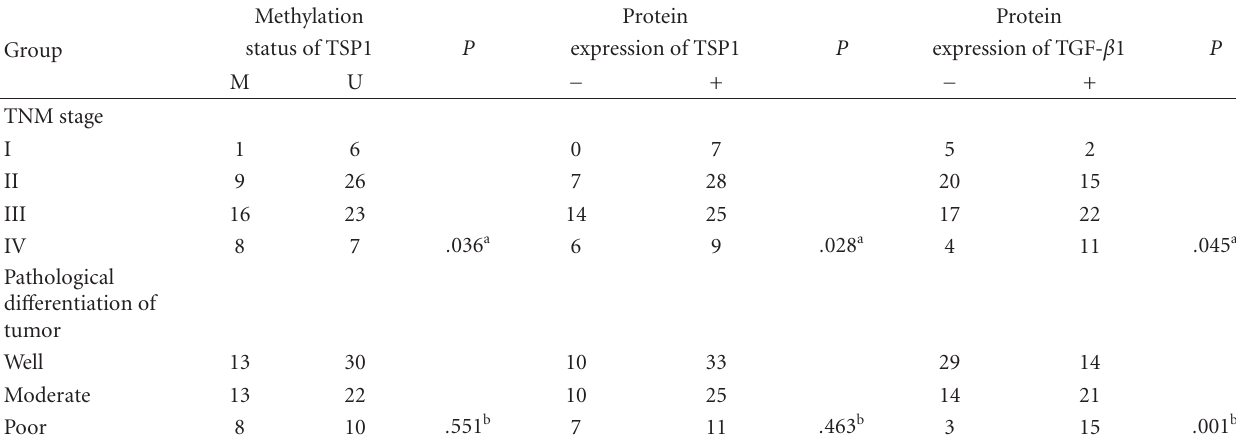
Table 1: Methylation status, immunohistochemical staining characteristics of TSP1, and immunohistochemical staining characteristics of TGF- β 1 in GCA patients